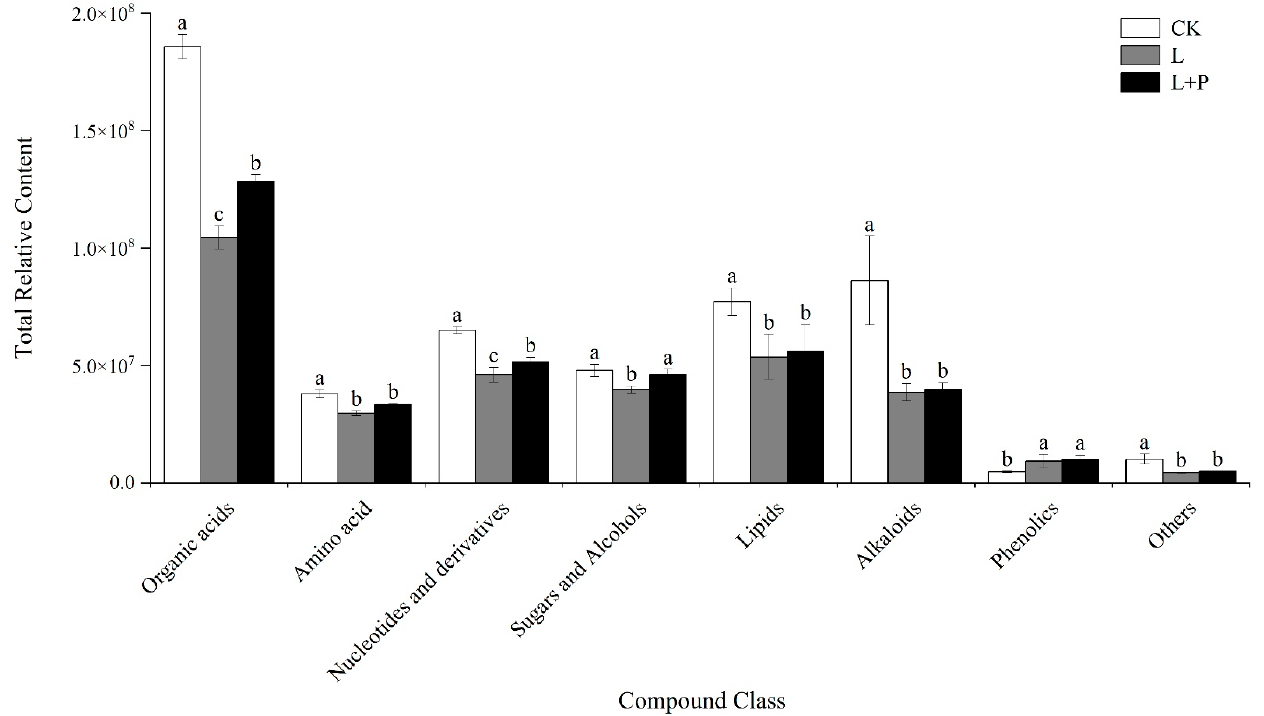
Figure 11. Changes in the total content of various major metabolites. Different small letters represent significant differences between treatments ( p < 0.05).